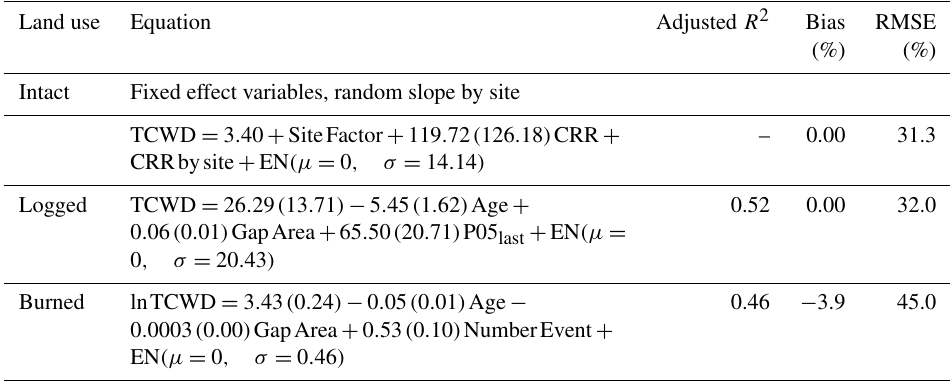
Table 5. Equations, adjusted R 2 , mean relative bias (%), and relative root mean square error (RMSE in %) of the historical scenario for predicting CDW in intact and degraded forests using Landsat and lidar variables. The parameters of the mixed-effect model for intact forests are shown in Table B1 in the Appendix. Age is the number of years since the last disturbance event. Gap area is total gap area in square meters per hectare. P05 last is the fifth percentile of the last returns . NumberEvent is the count of degradation events. CRR is canopy relief ratio. EN is the residual following a normal distribution with µ and σ . Estimated parameters by each site (fixed effect) are found in Table